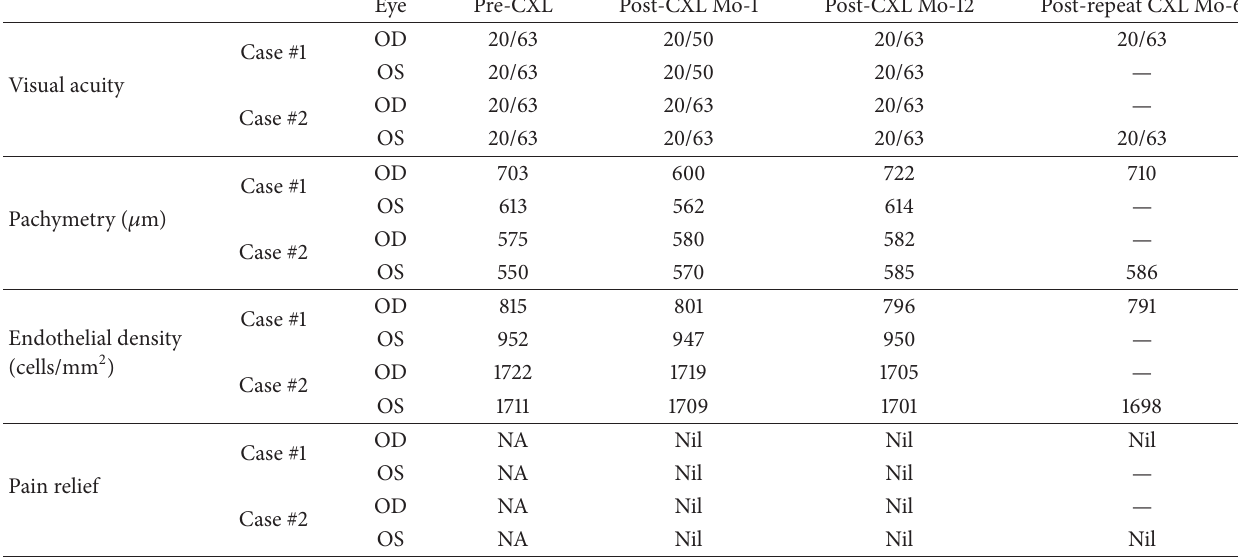
Table 1: Summary of the outcomes of collagen crosslinking procedures in Case #1 and Case